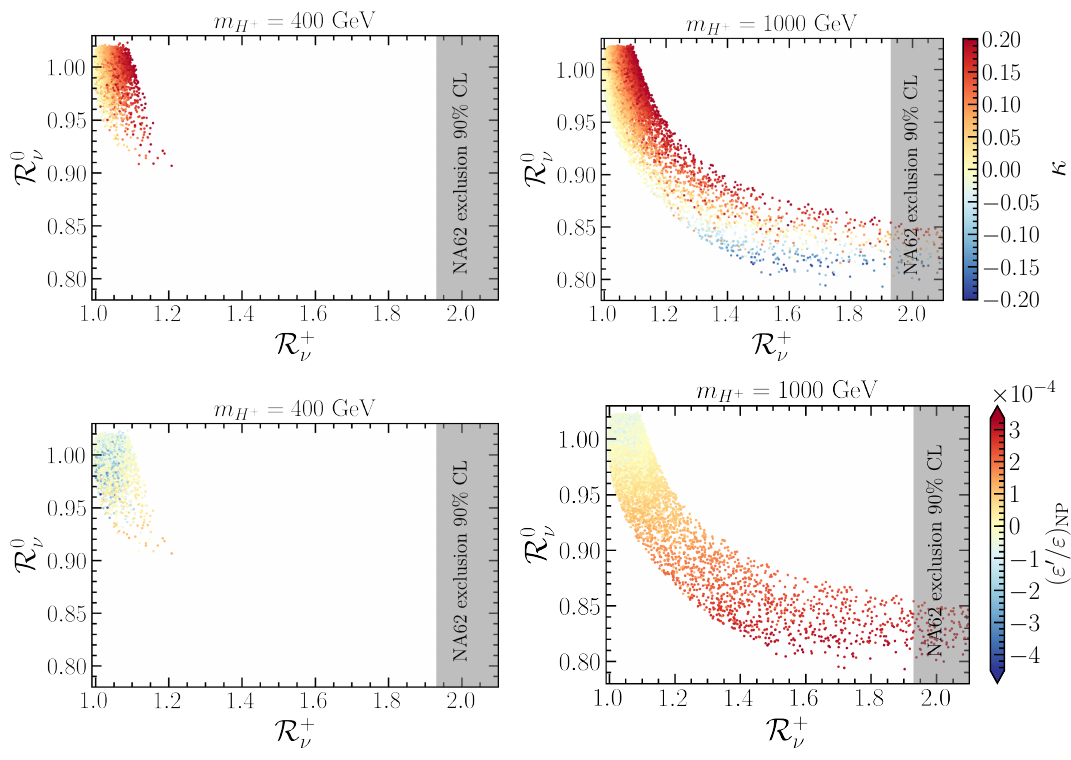
Figure 8 . Correlations between K + → π + ν ¯ ν , K L → π 0 ν ¯ ν , and κ (upper) and ( ε 0 /ε ) NP